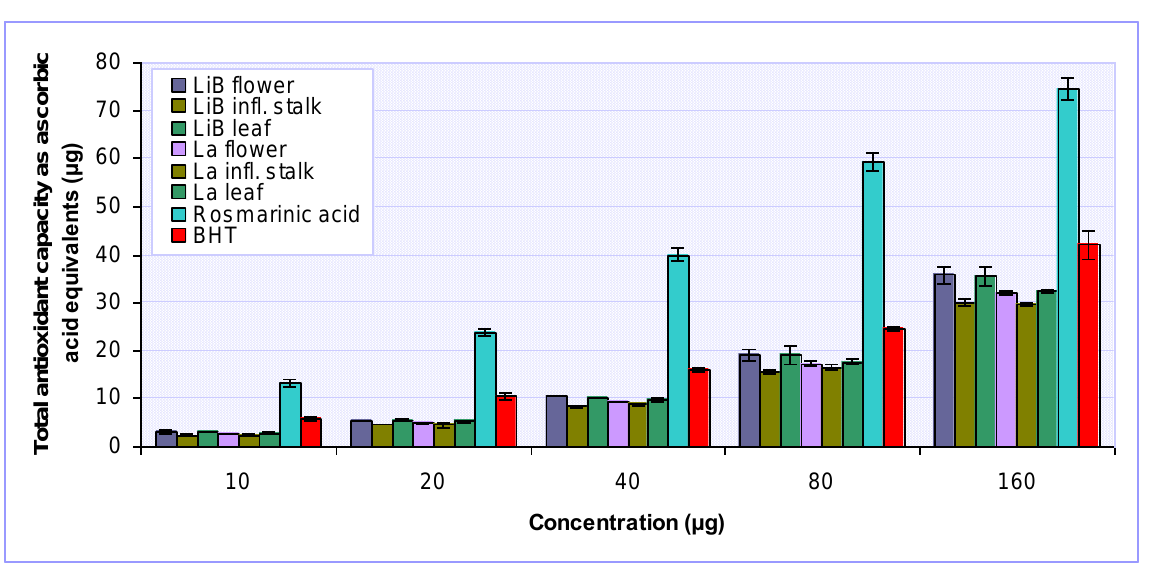
Figure 6. Total antioxidant capacity of various L. x intermedia 'Budrovka' (LiB) and L. angustifolia (La) extracts and rosmarinic acid. BHT was used for